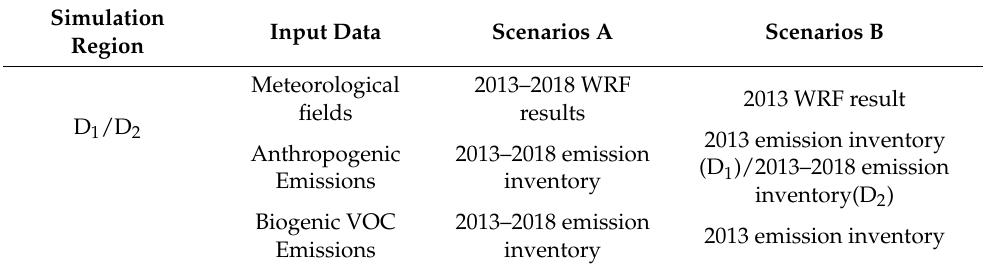
Table 1. Model simulation